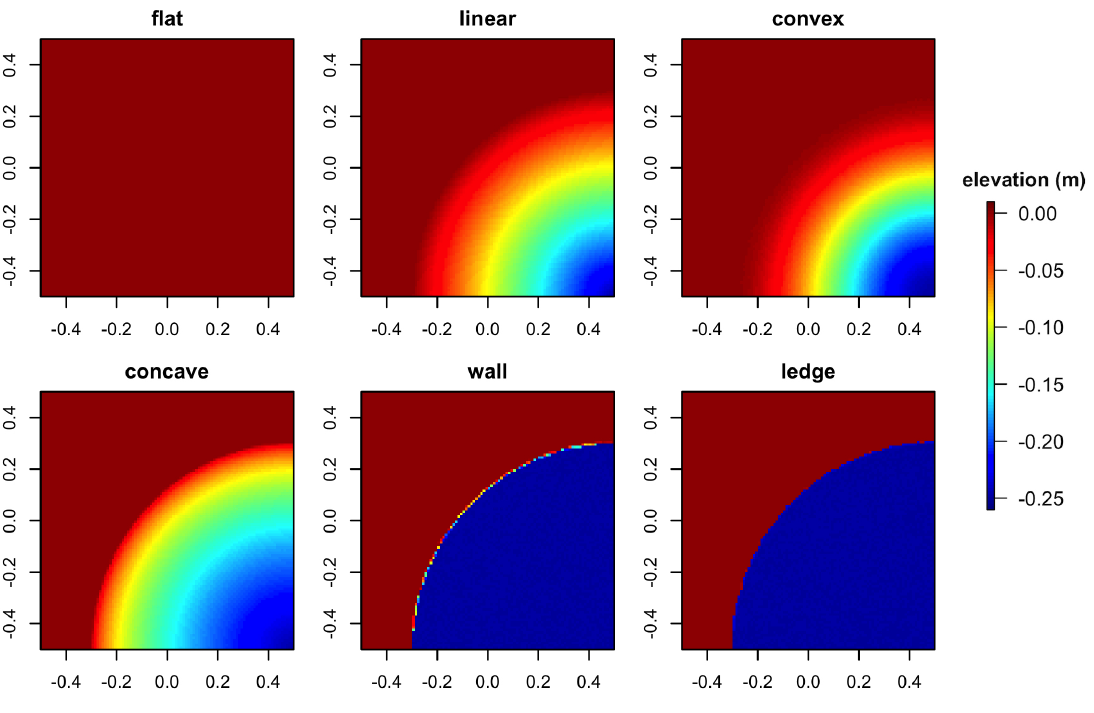
Figure 4. Digital Elevation Models obtained from the six simulated surface structures: flat, linear, convex, concave, wall and overhanging ledge.